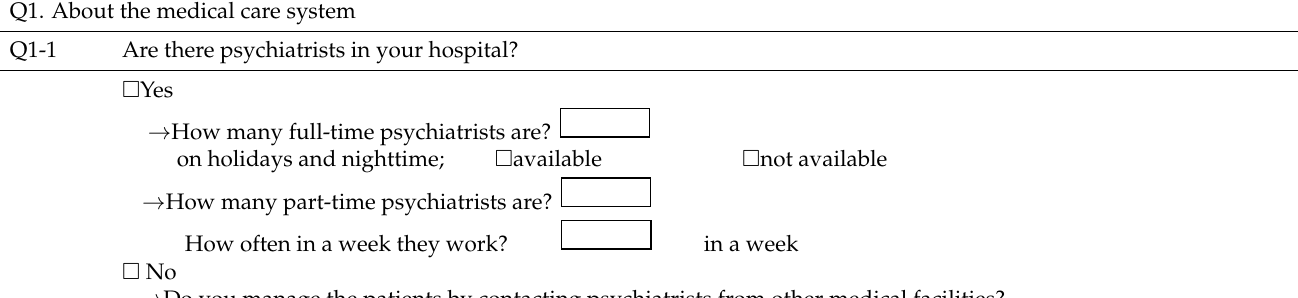
Table A1. Questionnaire for maternity care units.